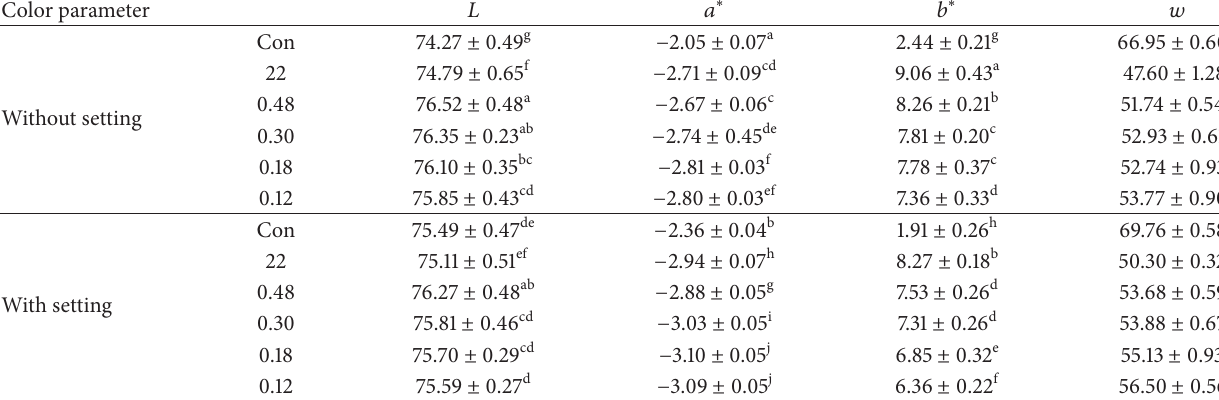
Table 1: Color parameters (lightness ( 𝐿 ), greenness ( 𝑎 ∗ ), yellowness ( 𝑏 ∗ ), and whiteness ( 𝑤 )) of silver carp surimi gels with different size of fish bone particles ( 𝜇 m) and thermal treatments. Color parameter 𝐿 𝑎 ∗ 𝑏 ∗ 𝑤